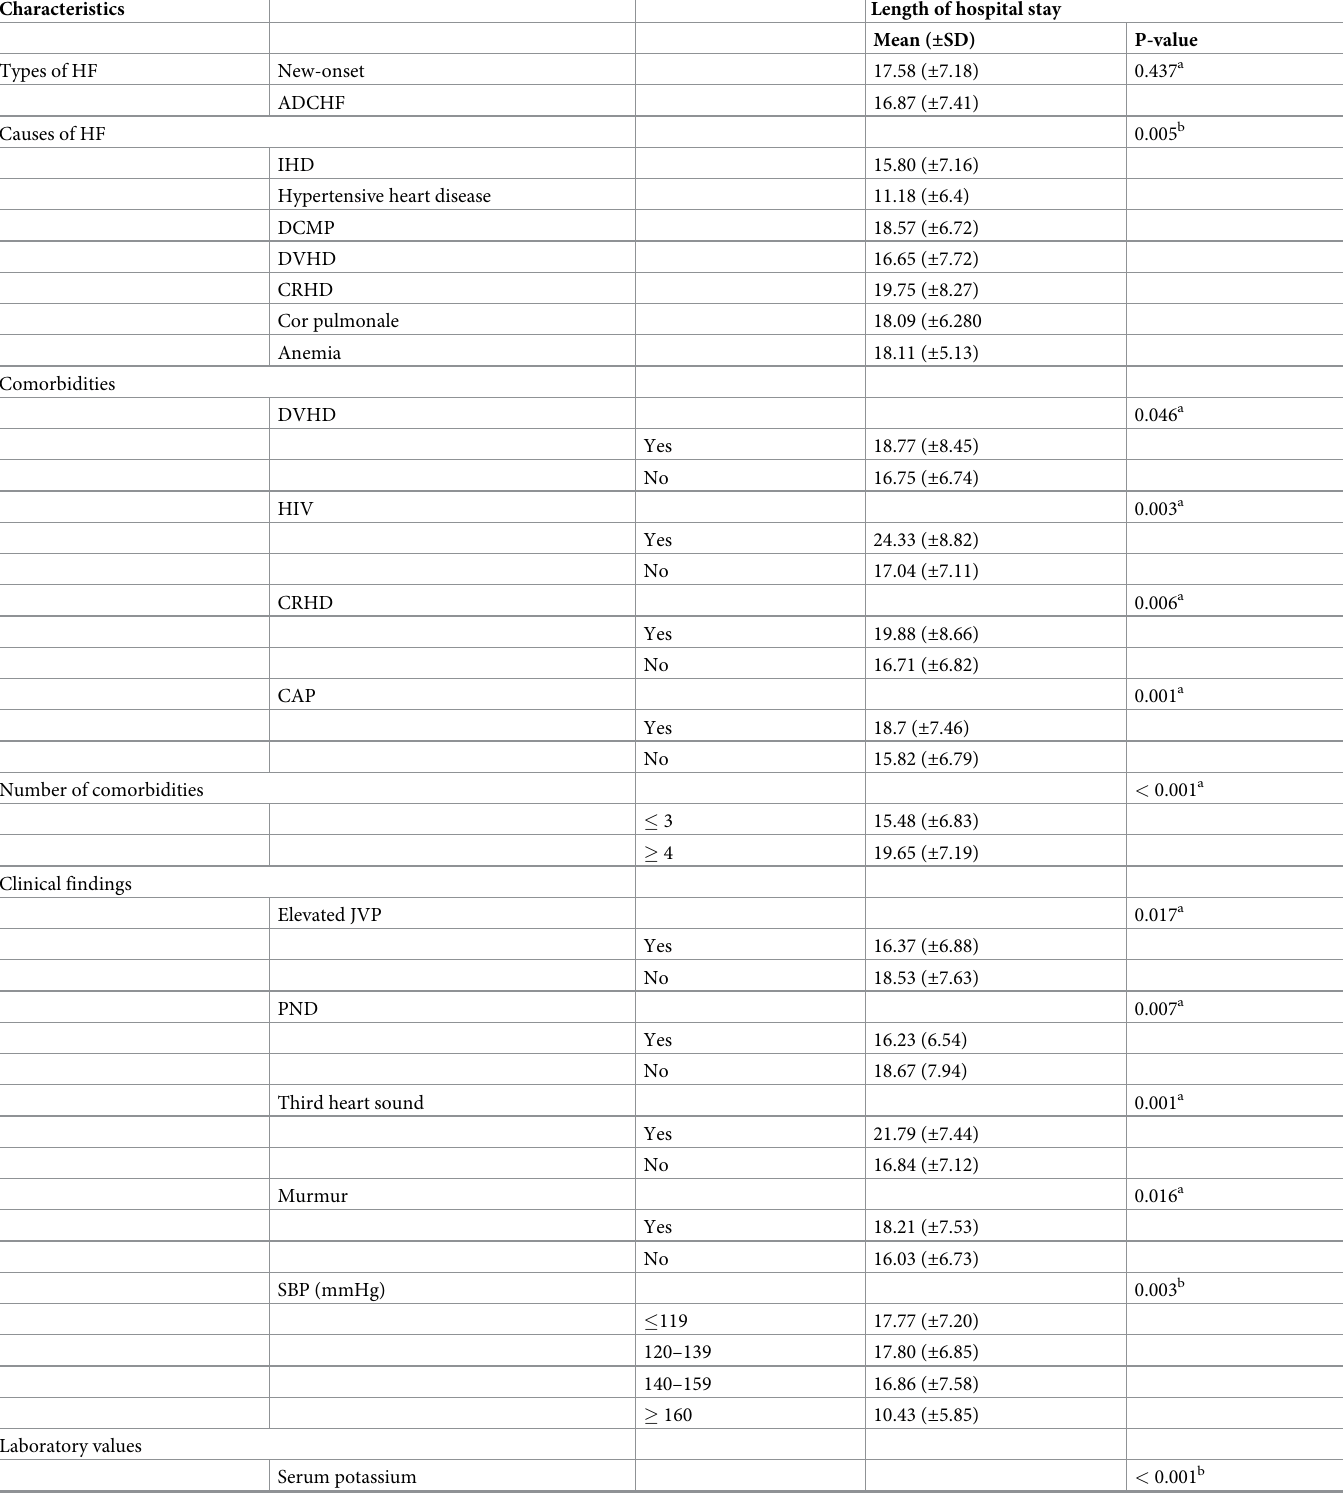
Table 2. Association of clinical factors with LOS among AHF patients admitted at UOGCSH medical ward.